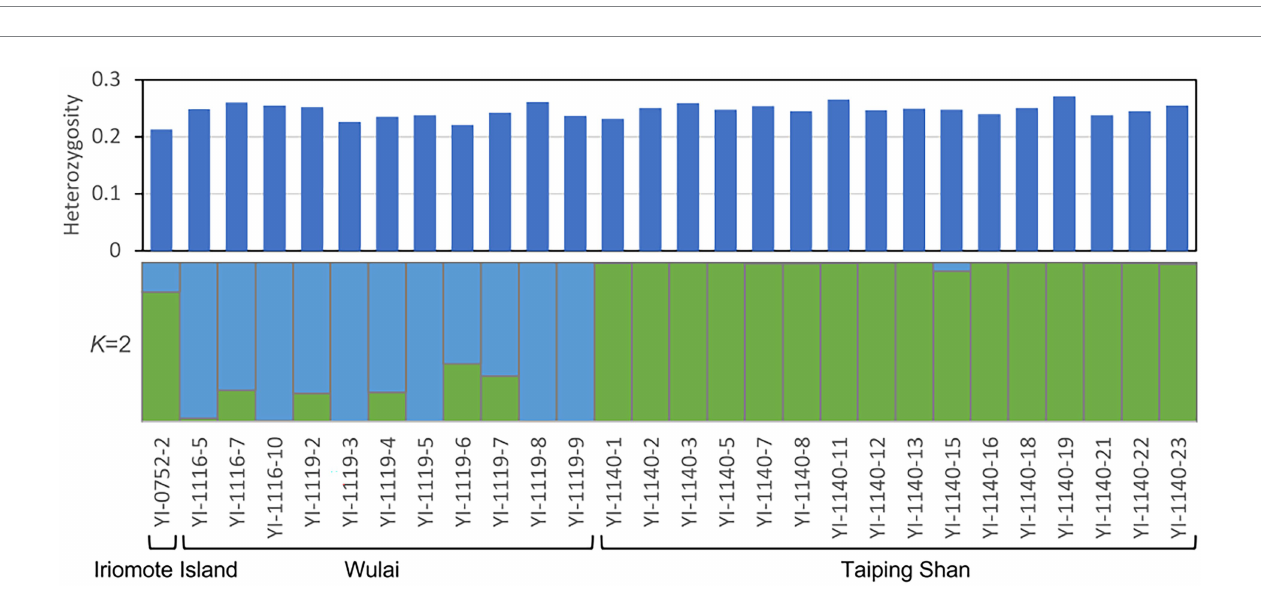
FIGURE 5 Heterozygosity at individual level and genetic structure analysis ( K = 2) of E. platyphyllum on genotypes at the 3,404 SNPs. Heterozygosity at individual level was calculated by TASSEL version 5 and genetic clustering was performed by STRUCTURE version